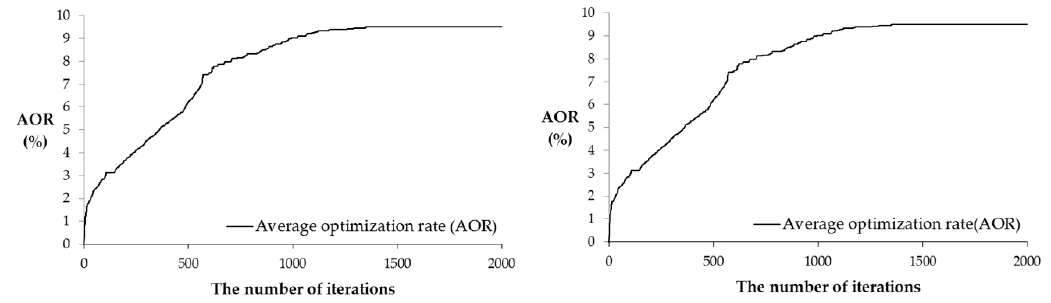
Figure 7. Model optimal curve.